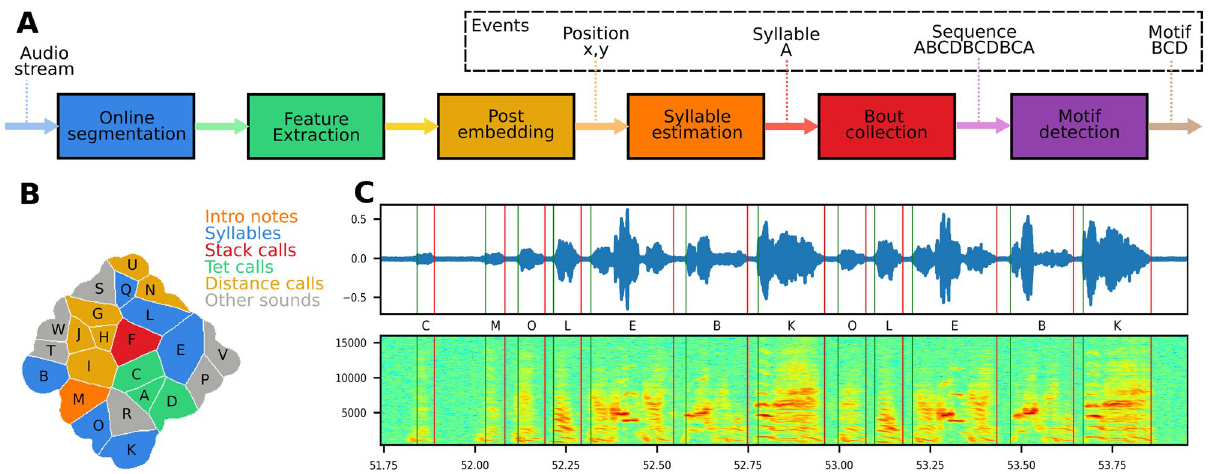
Figure 5. Analysis pipeline for real-time motion detection. ( A ) The pipeline for analysis uses the methods described in Fig. 4A–E for segmentation and feature extraction. The resulting feature vector is post-embedded in the 2D space and classified based on which region it falls within. Syllables are collected in sequences and screened for motifs. ( B ) The behaviour map annotated manually based on sample sound segments from each region. ( C ) Song spectrogram with vertical lines indicating onset (green) and offset (red) events of automatically detected syllables. The letters indicate the class of the